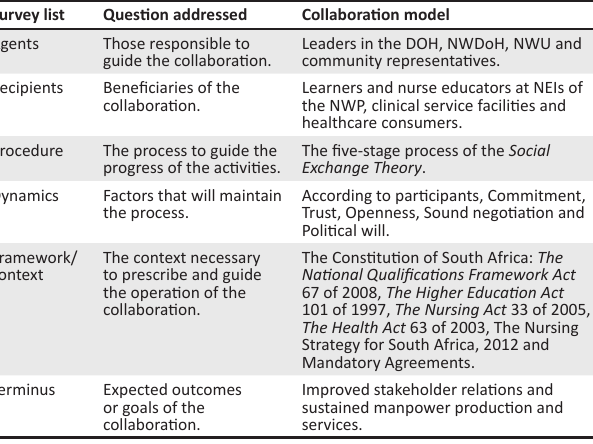
FIGURE 5: A schematic presentation of the collaboration model between nursing education institutions in the North West Province. TABLE 3: Activity aspects as related to the framework model of